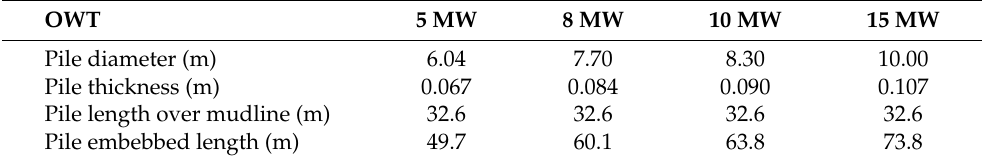
Table 3. Definition of the set of monopiles supporting each of the OWTs used in the present study. OWT